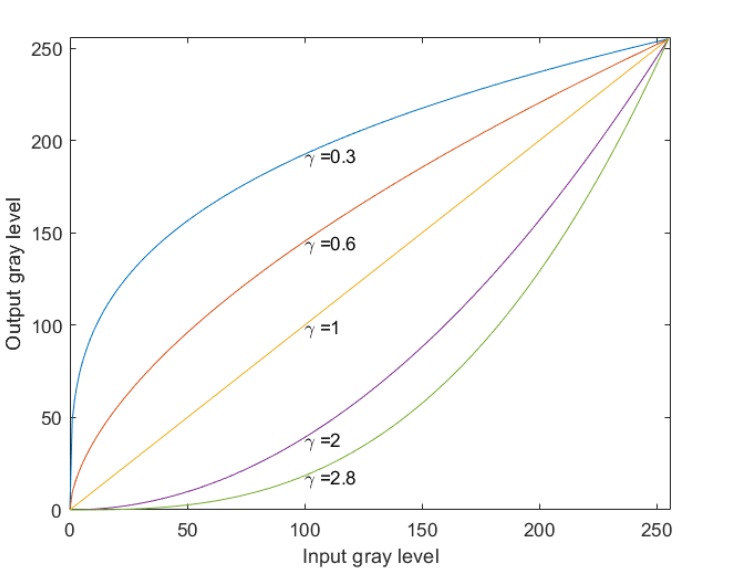
Figure 2. Gamma correction